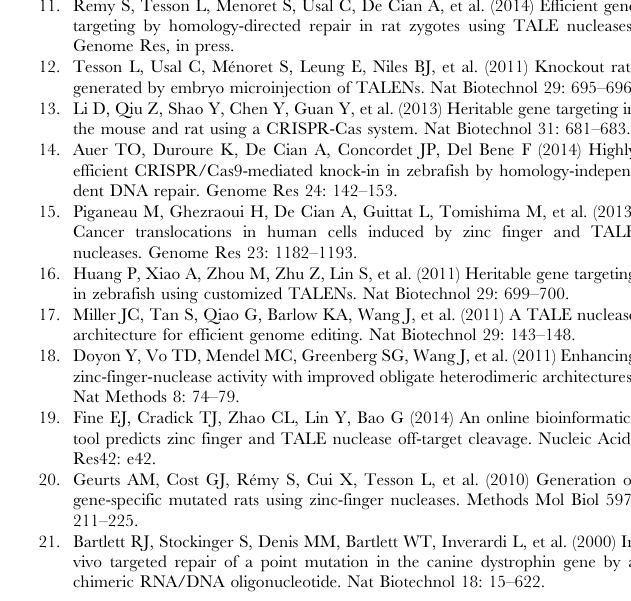
Figure S5 Abnormal fiber type pattern in Dmd mdx rats. Compared to wild-type littermate control (WT) rats, biceps femoris muscles from 7-month-old Dmd mdx rats were characterized by type 1 predominance and grouping (type 1 fibers in black) and abnormal presence of type 2C (intermediate grey staining, open arrowhead). ATPase staining, pH 4.35. Bar= 100 m m. (TIF) Figure S6 Dystrophin messenger RNA expression in skeletal muscles and hearts of Dmd mdx rats. Dystrophin mRNA was detected by nested RT-PCR from exon 22 to 24 in tibialis cranialis muscles and in hearts sampled in 7 month-old Dmd mdx rats and wild-type control littermates. No skipping of the mutated exon 23 was detected in muscles from Dmd mdx rats. (TIF) Table S1 Efficacy of generation of Dmd mutants by TALE nuclease microinjection. (DOC) Table S2 Dmd mutations and potential off target sequences analyzed in founder